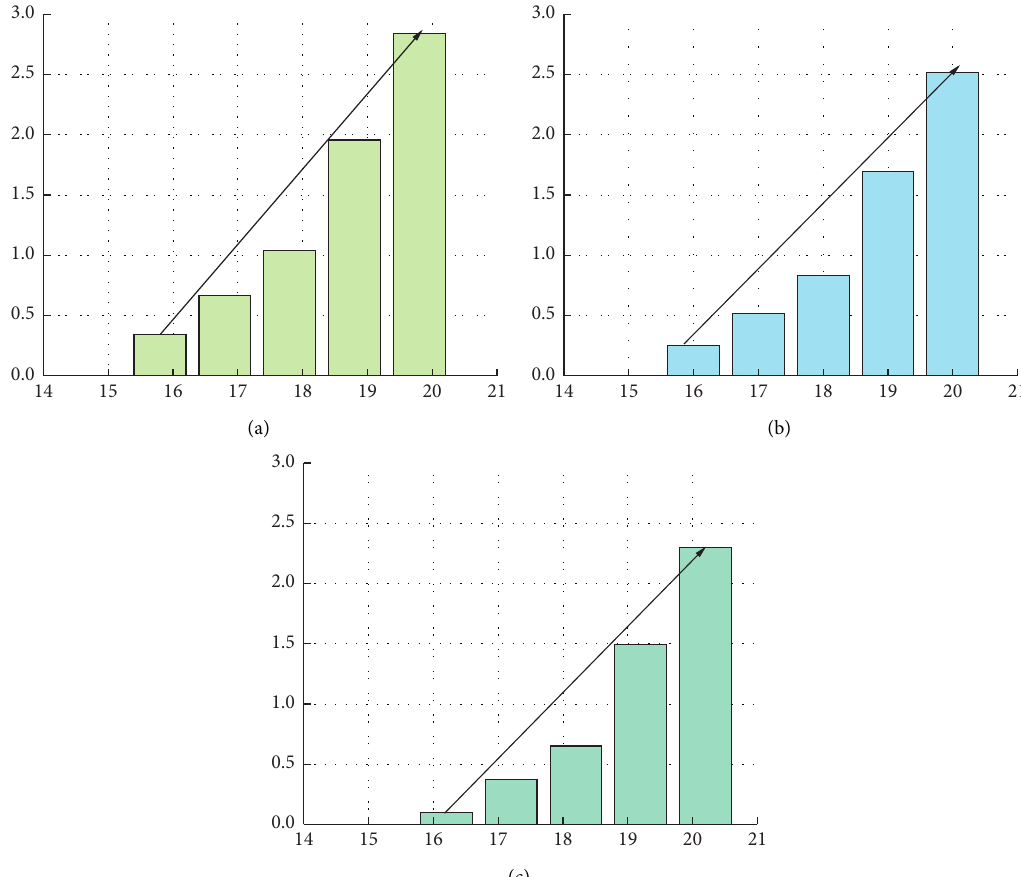
Figure 8: Residuals. (a) Original model. (b) Improved model 1. (c) Improved model